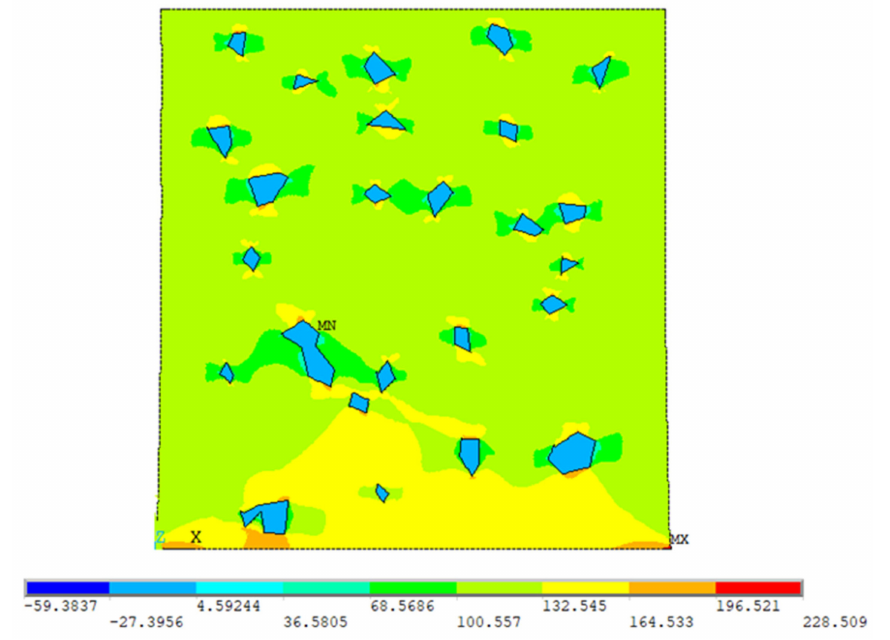
Figure 14. The hydrostatic pressure (MPa) of RVE